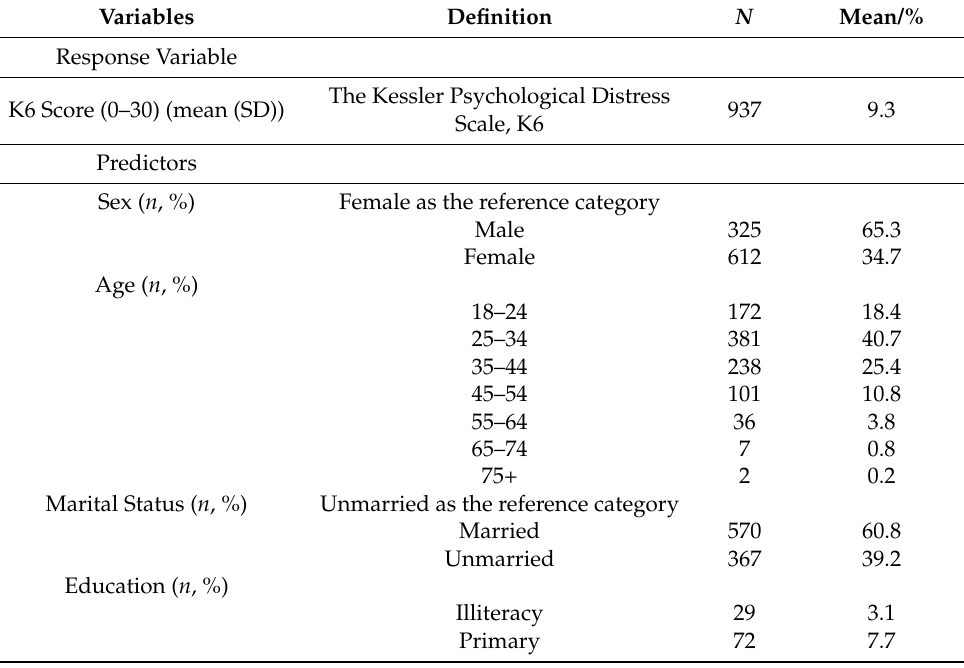
Table 1. Definition and descriptive characteristics of variables conducted in this